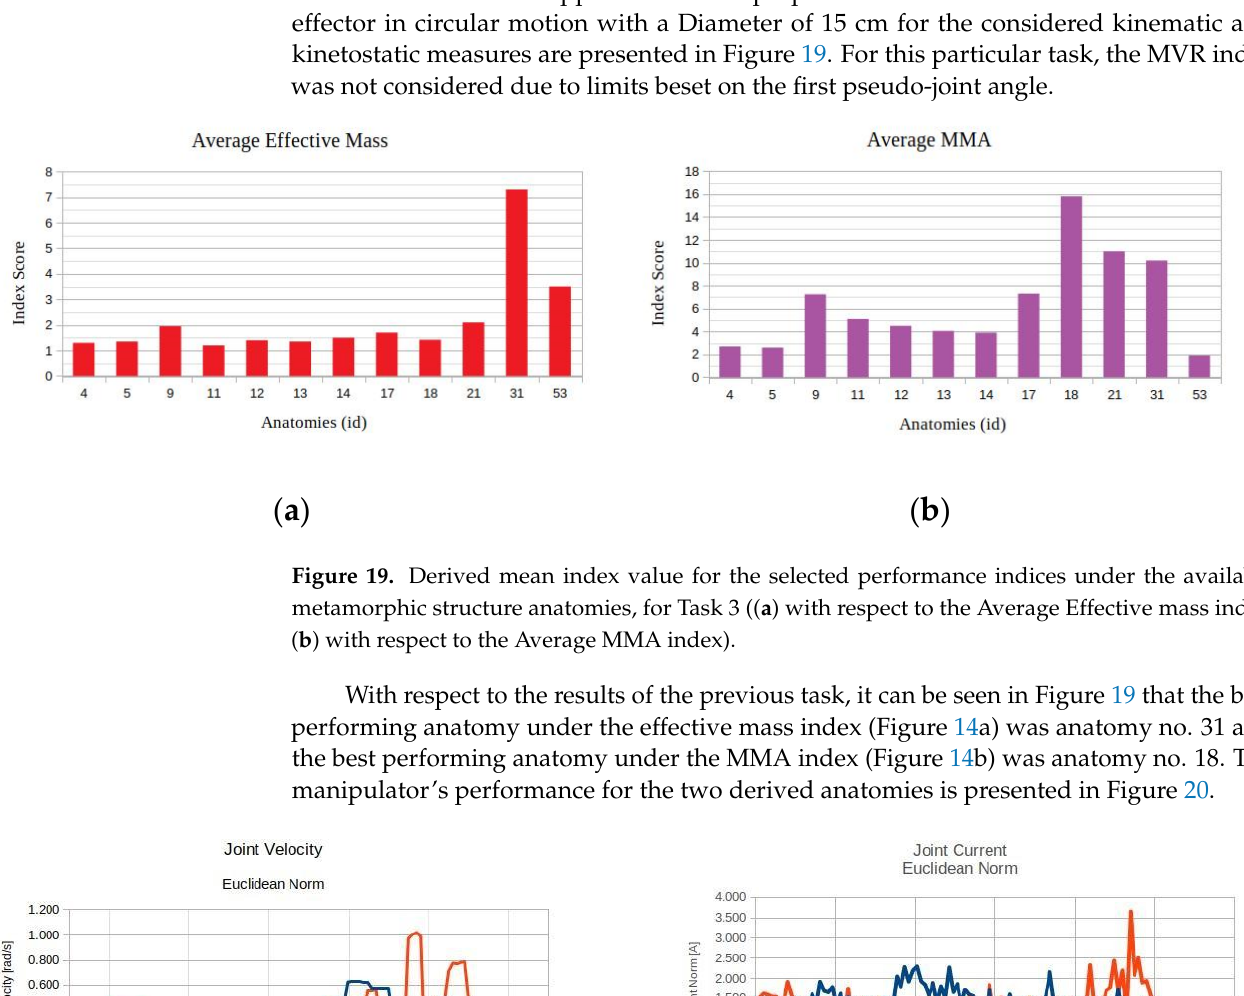
18 of 26 Figure 17. Optimal anatomy of the metamorphic manipulator derived under the effective mass and MMA measure for Task 2. Figure 18. Optimal anatomy of the metamorphic manipulator derived under the MVR measure for Task 2. As seen in Figures 17 and 18, the anatomies derived under each measure are signifi-